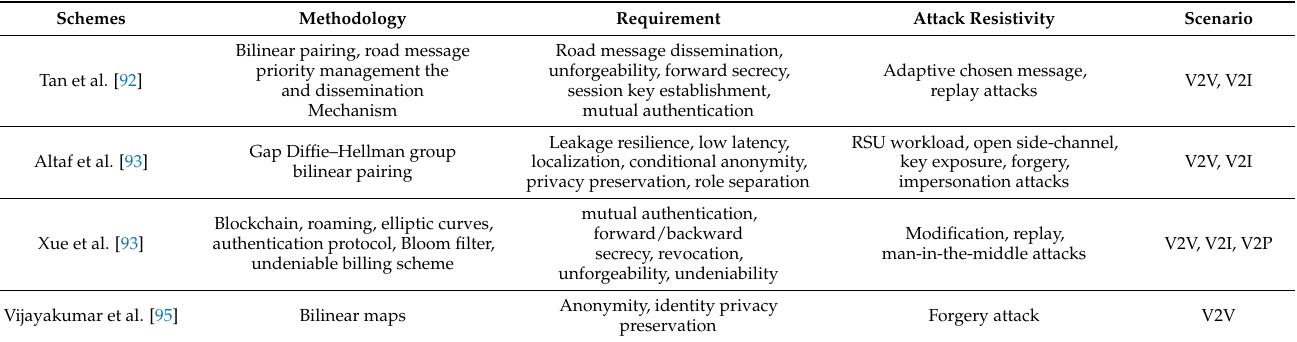
Table 7. Classification of hybrid-authentication-based certificate-less aggregate signature